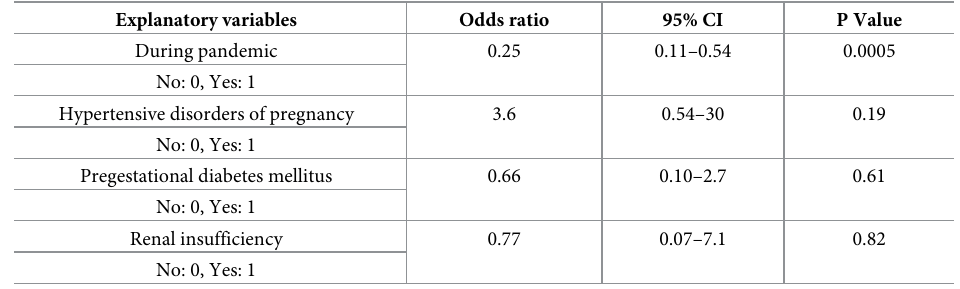
Table 5. Logistic regression analysis of risk factors for infants with FGR.